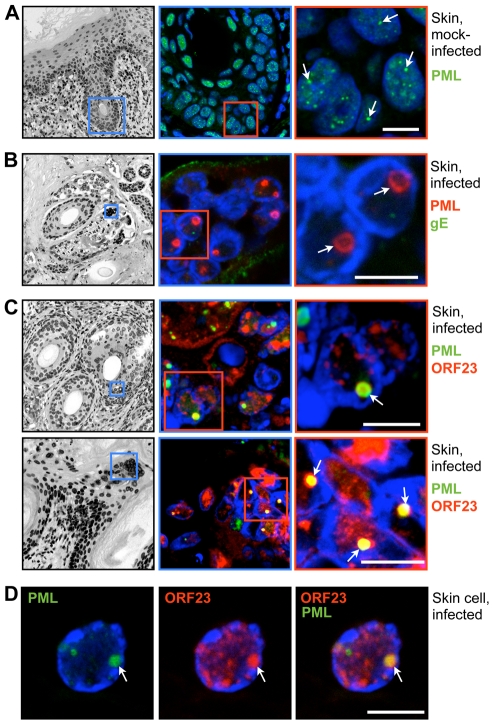
PML cages sequester VZV nucleocapsids during infection of human skin.Human skin xenografts in the SCID mouse model were collected 21 days after mock infection (A) or inoculation with VZV (B–D). Thick (5 µm) paraffin sections were analyzed by confocal IF microscopy after staining for PML (A), double-IF staining for PML and the VZV glycoprotein gE (B) or double-IF staining for ORF23 and PML (C and D), as indicated at the right of each row of panels. Nuclei are stained with Hoechst (blue). Images in A-C (left panels) are overviews of the same skin sections, including epidermal and dermal layers and hair follicles, after Hoechst staining (inverted grey scale). Blue and red squares demark areas shown at higher magnification in the panels on the right. Arrows indicate PML-NBs in the nuclei of skin cells. (A) Uninfected skin cell nuclei contain several small PML-NBs (green). (B) Infected cells have fused to form the syncytia (polykaryons). Large ring-like PML-NBs (red) are visible and VZV glycoprotein gE (green) is expressed on plasma membranes. (C) Large ring-like PML-NBs (green) sequester ORF23 protein (red). (D) A single skin cell nucleus showing PML-NBs (green) and ORF23 protein (red). All scale bars are 5 µm.